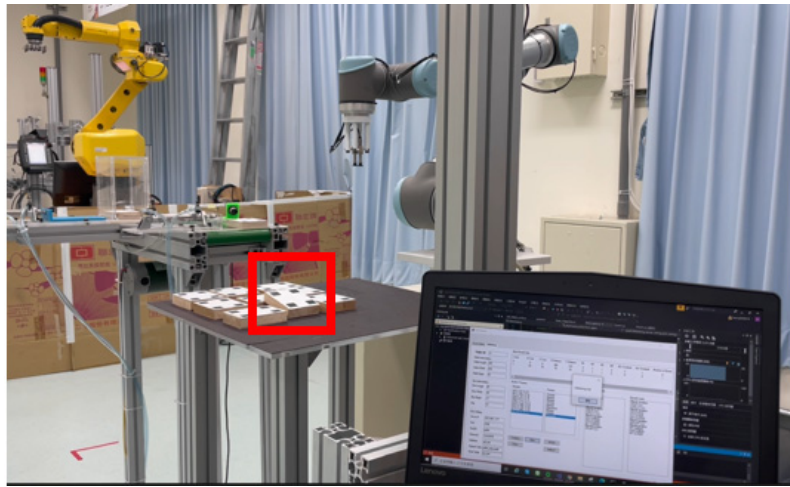
Figure 38. Failed palletizing in workstation.